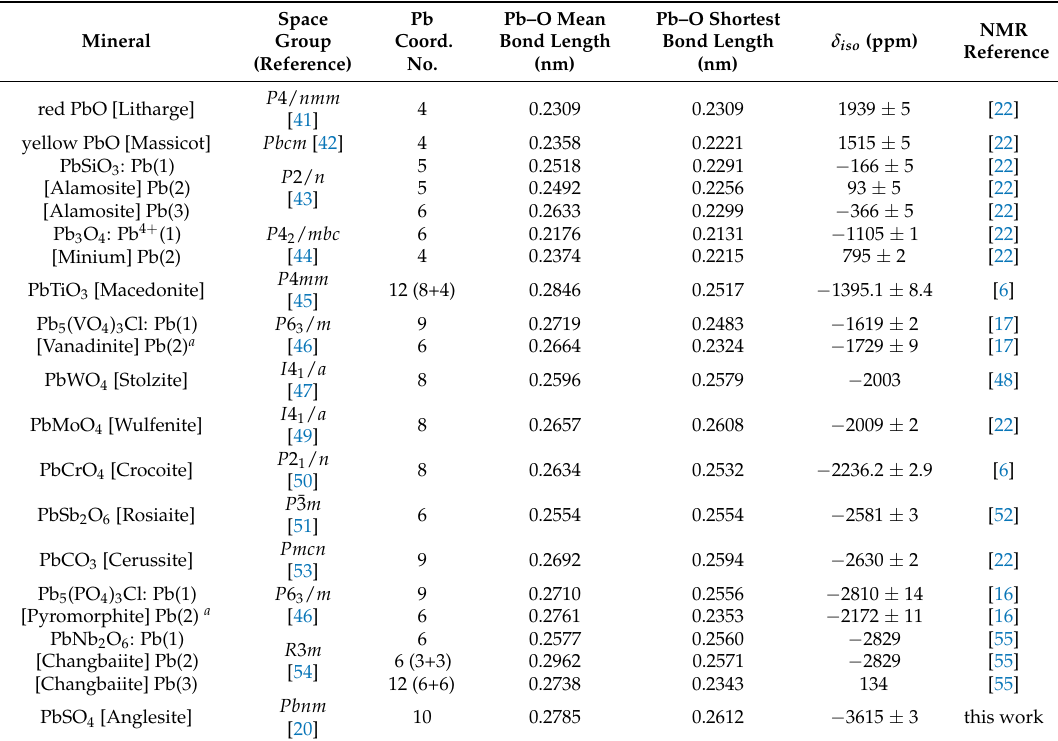
Table 2. Crystallographic data and 207 Pb isotropic chemical shifts δ iso of lead-bearing minerals. The first co-ordination sphere of at least one lead side for each compound is solely determined by the next neighbouring oxygen